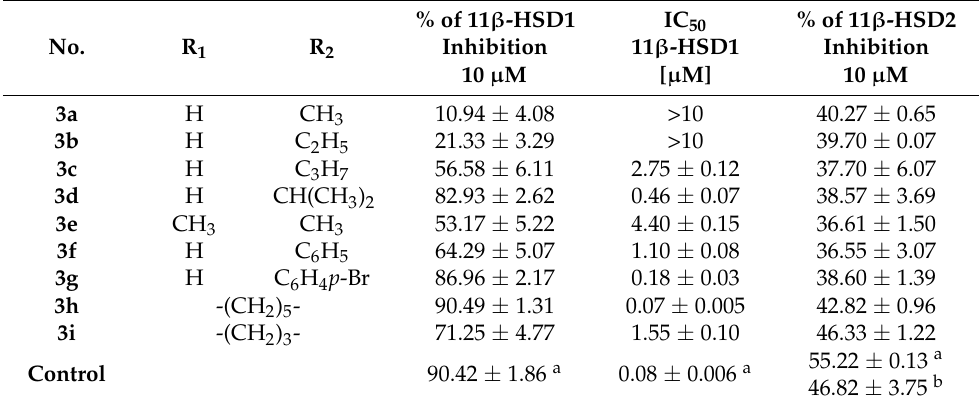
Table 2. Inhibitory activity of 2-(cyclopentylamino)thiazol-4(5 H )-one